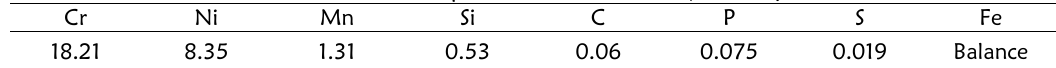
Table 2: Chemical composition of the stainless (AISI 304) steel.